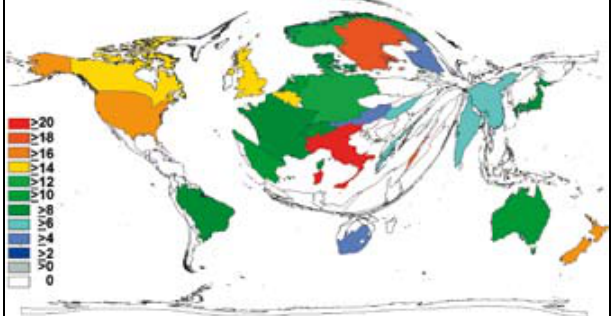
Fig. 4. Density-equalising map illustrating the average citation rate of the countries that published at least 30 papers on cannabis from 1900 to 2008. The area of each country was scaled in proportion to its average citation rate on cannabis